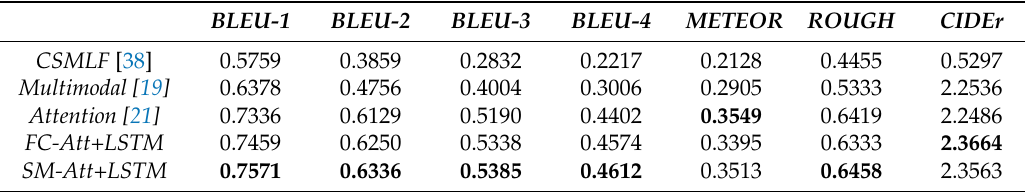
Table 3. Results of the baseline and our methods on